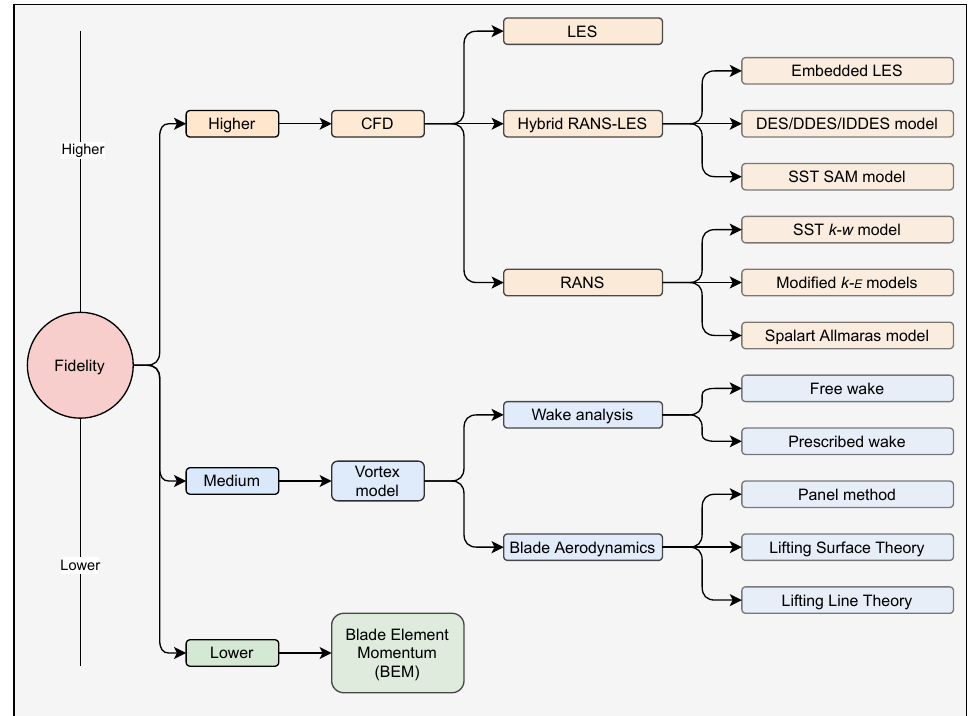
Figure 6. The WT aerodynamic models with their complexity and fidelity discussed in